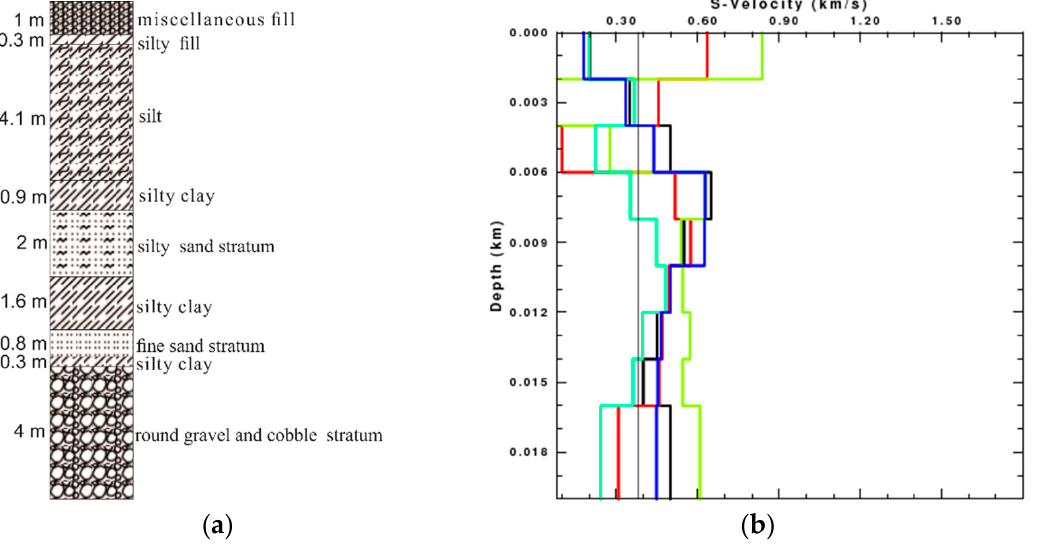
Figure 14. Field data test: ( a ) the lithologic histogram; ( b ) inversion results using the radial (red line), vertical (yellow line), rotational (green line), and multi-component (blue line) seismic data, respec- tively. The black thick line is the actual S-wave velocity, and the black thin line is the initial S-wave velocity. Table 4. Error of the inversion results using the radial (X), vertical (Z), rotational (R y ), and multi- component (X + Z + R y ) seismic data.